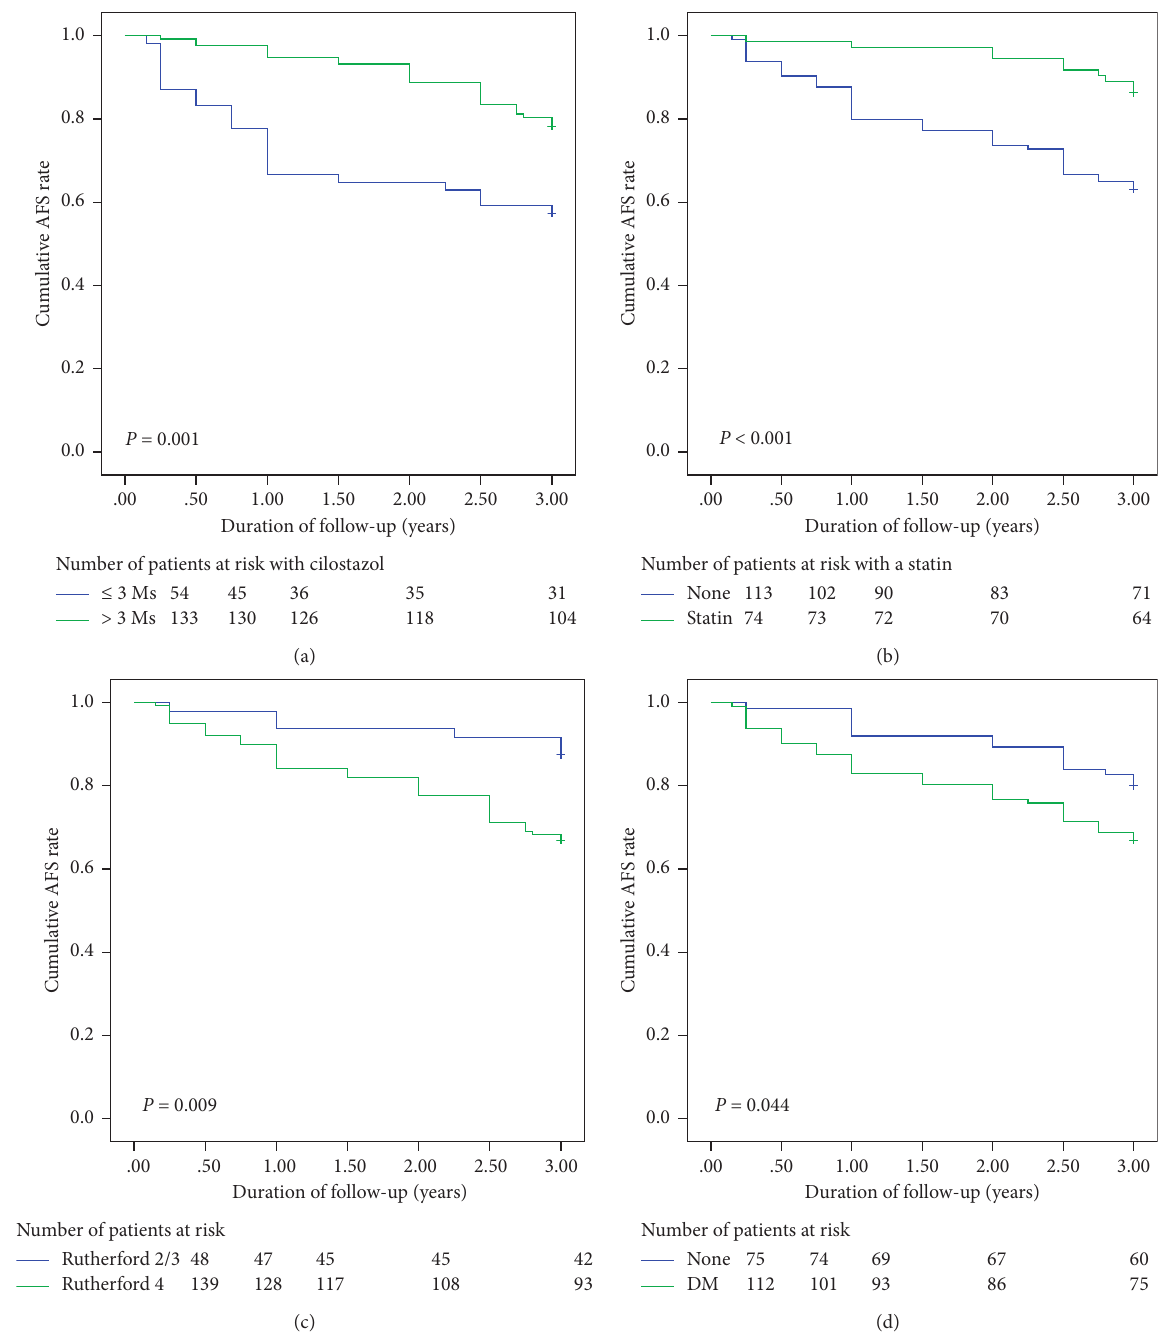
Figure 2: (a) Patients who received cilostazol treatment for more than 3 months had a better 3-year amputation-free survival (AFS) rate than patients who received treatment for fewer than 3 months (log rank test, P � 0 . 001). (b) Patients receiving statin treatment had a superior 3-year AFS rate to those who did not receive treatment (log rank test, P < 0 . 001). (c) Patients who presented with TASC D peripheral artery disease (PAD) had an inferior 3-year AFS rate than patients who had TASC B plus C PAD (log rank test, P � 0 . 009). (d) Patients with diabetes mellitus had a poorer 3-year AFS rate than patients without DM (log rank test, P � 0 . (D) patients with diabetes mellitus had a poorer 3-year AFS than patients without (log rank test, P � 0 . 044).